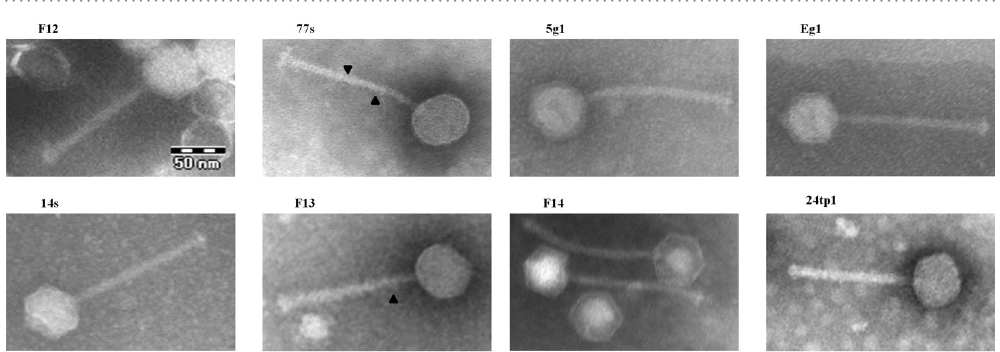
Figure 3. Electron micrographs of Lactococcus phages sequenced in this study. Arrowheads point to potential spiral-like structures around the phage